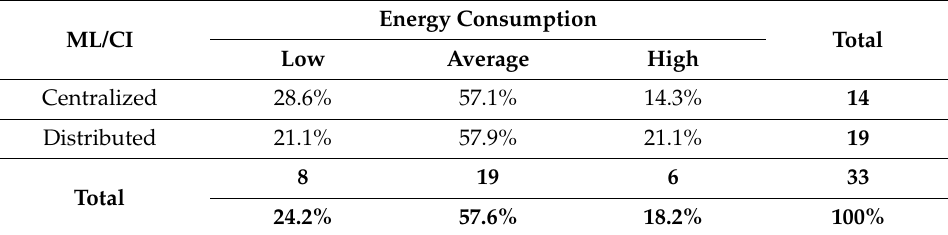
Table 4. Comparison of the energy consumption according to the nature of the approach. ML/CI